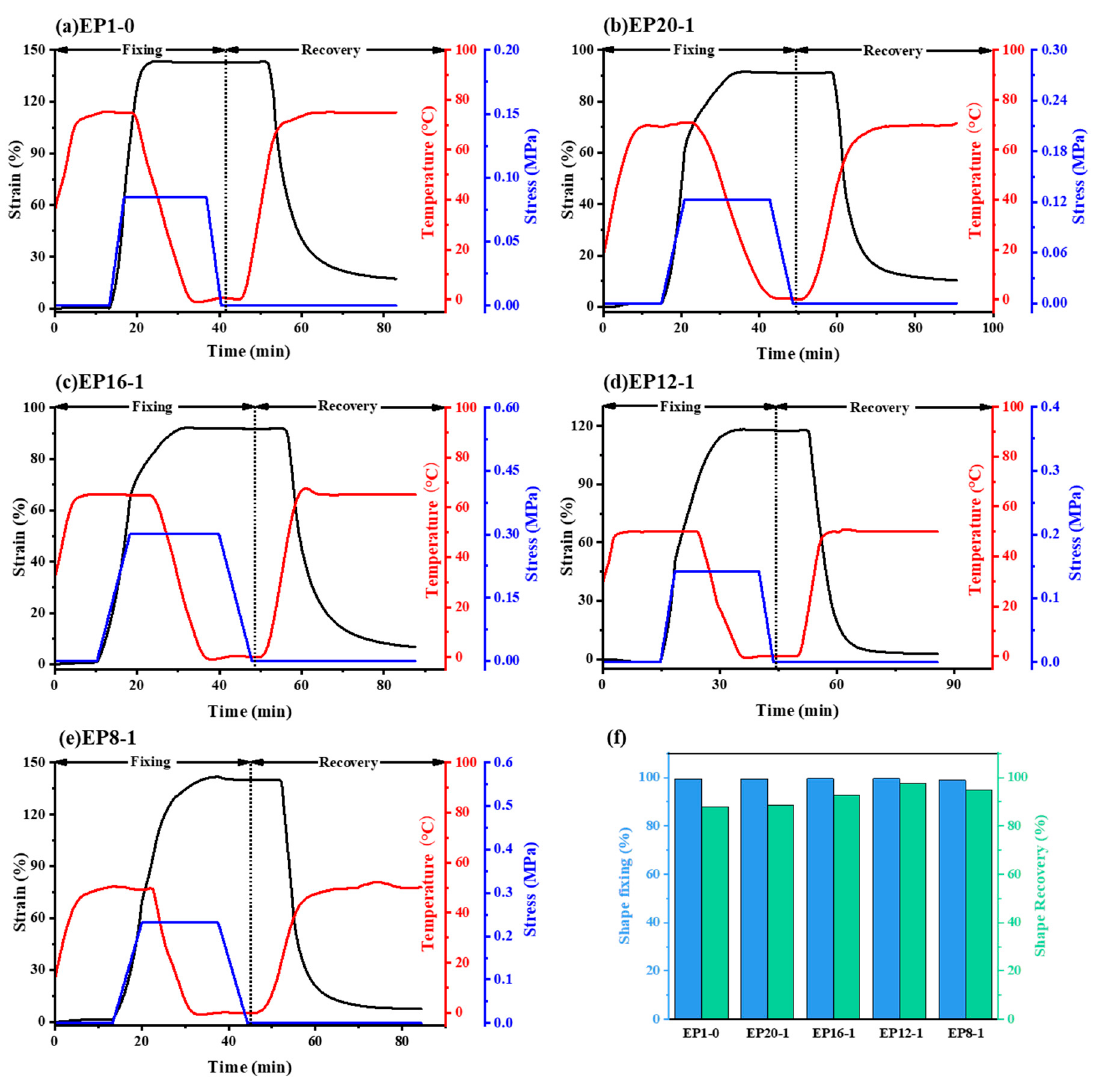
Figure 10. Shape memory curves ( a – e ) and statistics of shape memory properties ( f ) of EPx sam- ples.